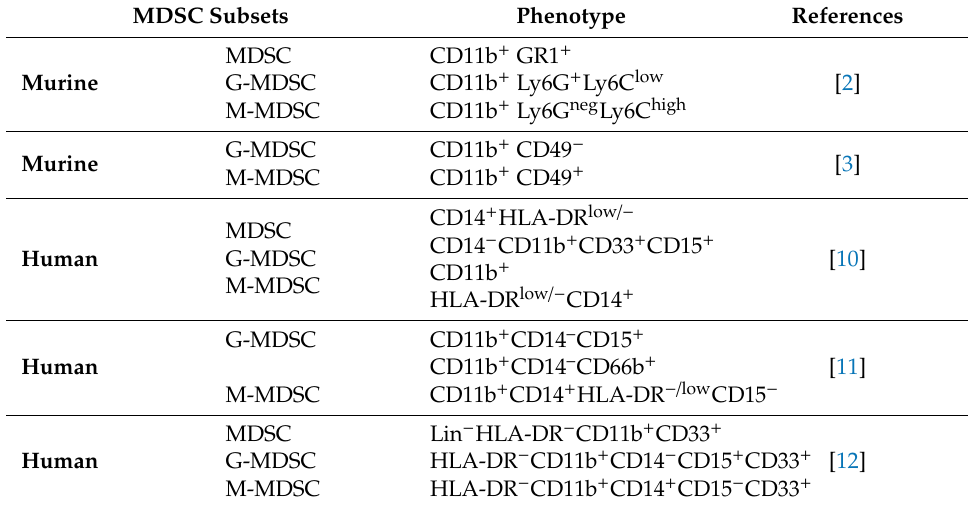
Table 1. Phenotype and functional proteins of murine and human